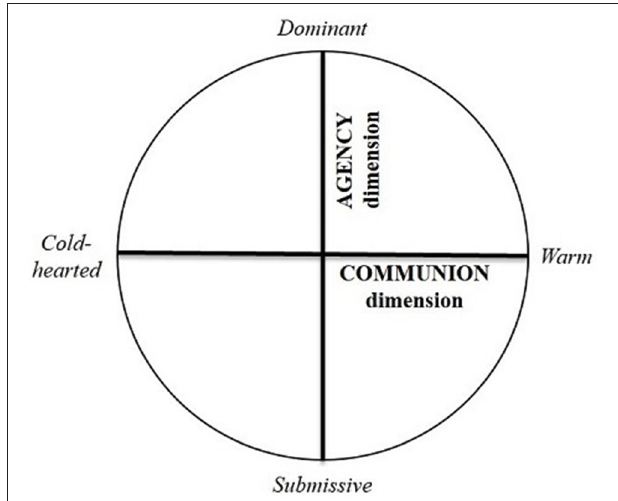
FIGURE 1 | The circumplex model. Presentation of the Circumplex Model (adapted from Wiggins, 1995), with the two interpersonal dimensions and the labels of the